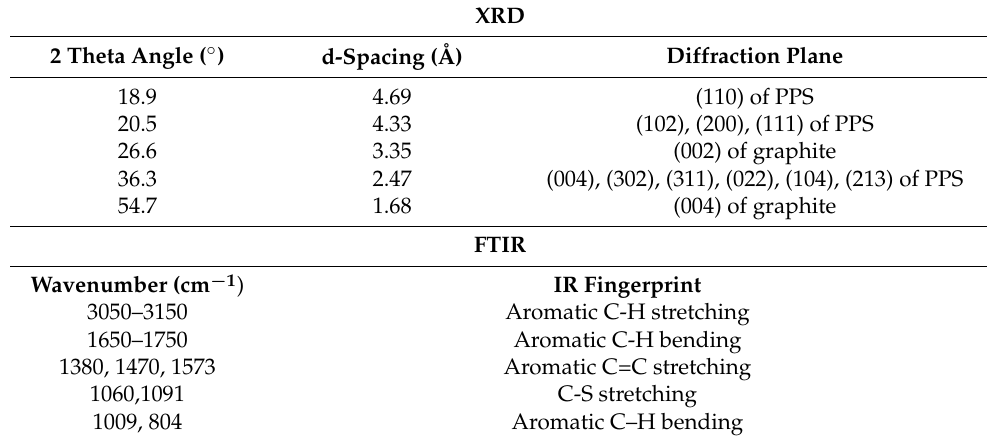
Figure 3. Structural analysis of the polymer composite. ( a ) XRD spectrum indicating a possible composite structure of PPS and graphite; ( b ) FTIR spectrum showing the presence of an aromatic structure with a carbon–sulfur bond; ( c ) 2D WAXS pattern and integrated 1D profile confirming an isotropic nature of the composite; and ( d ) 2D SAXS pattern and integrated 1D profile showing the presence of an assembled structure with correlation lengths between 67 and 121 Å. Table 1. XRD and FTIR peak assignment results for the characterized polymer composite.